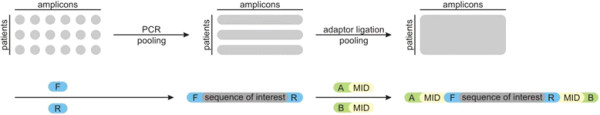
Workflow for the PCR enrichment approach. Amplicons are equimolar pooled per patient, continuously the A and B (454) adapters with MID are ligated to each pool of amplicons. All the patients, each tagged with a unique MID, can be pooled before proceeding to emulsion PCR.